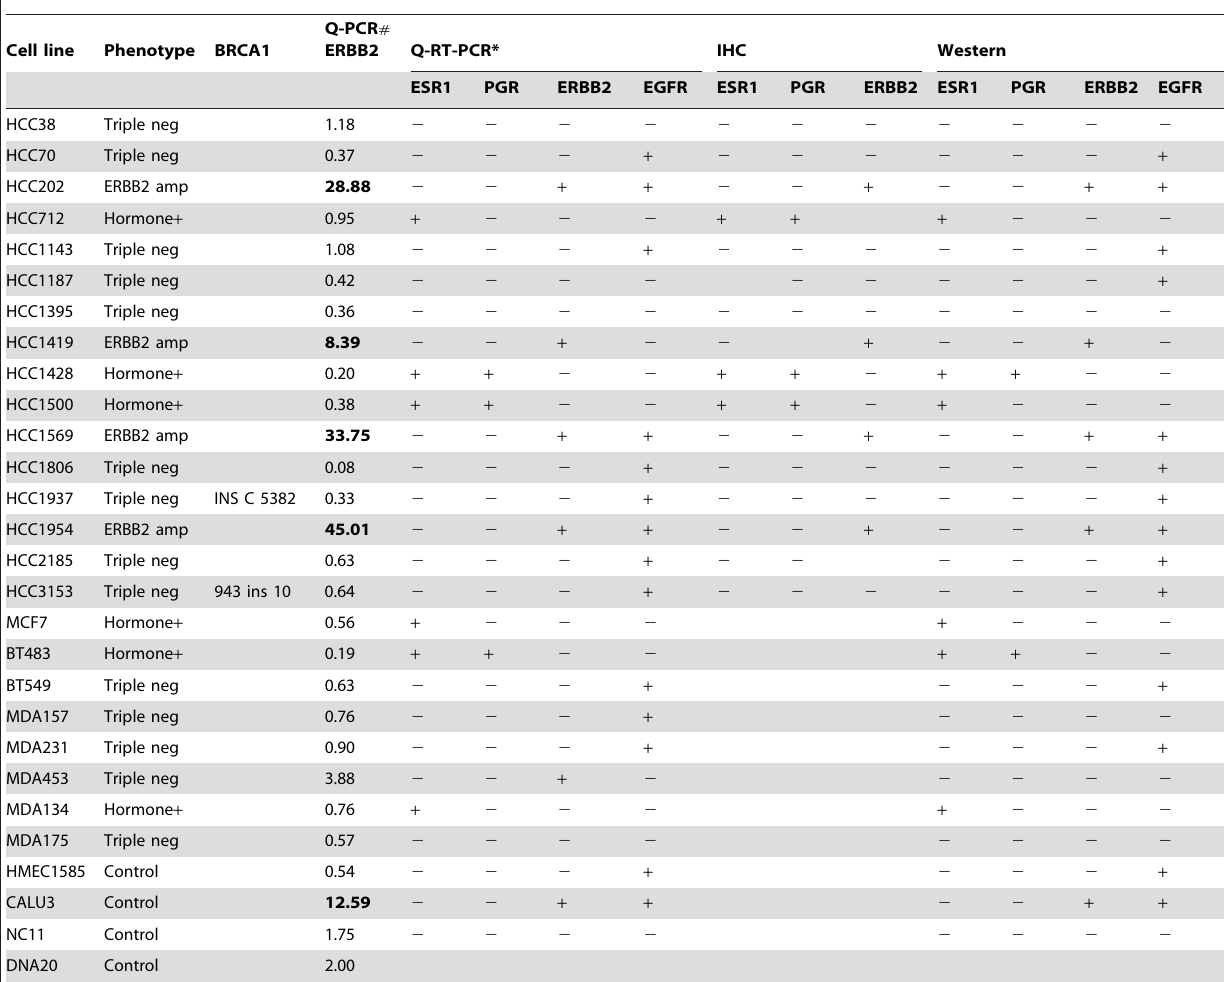
Table 2. Molecular pathological analysis of breast cancer cell line subset.